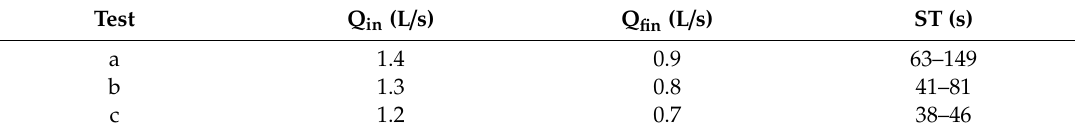
Table 2. Stabilisation time intervals (or STs) for tests (a), (b) and